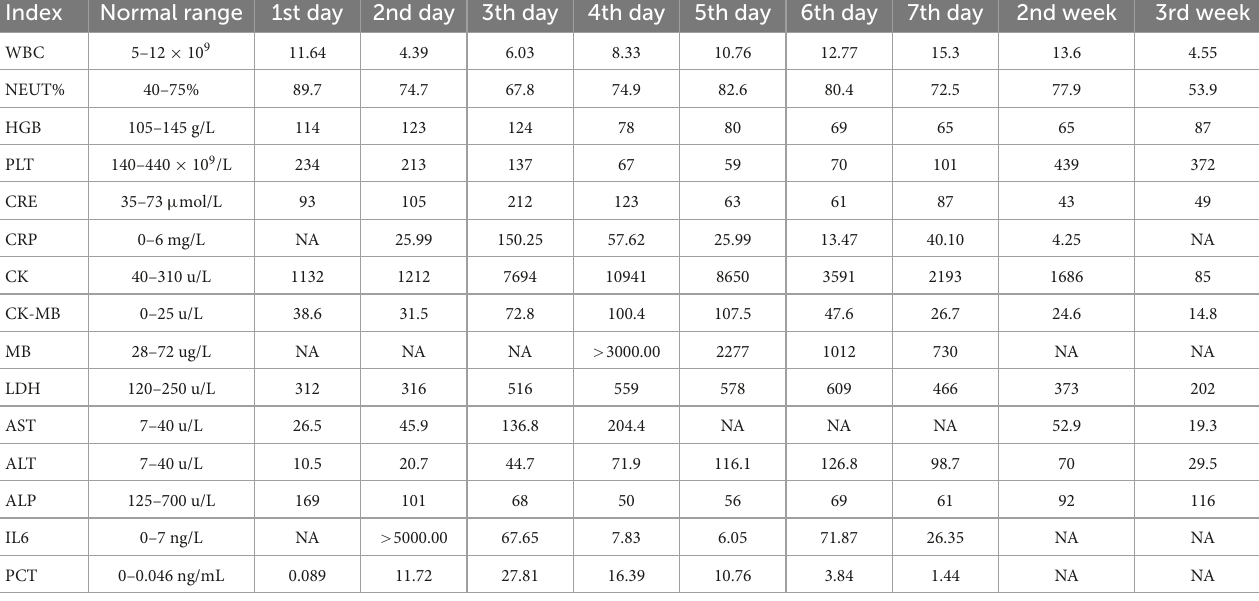
TABLE 1 Changes in the patient’s laboratory test results during